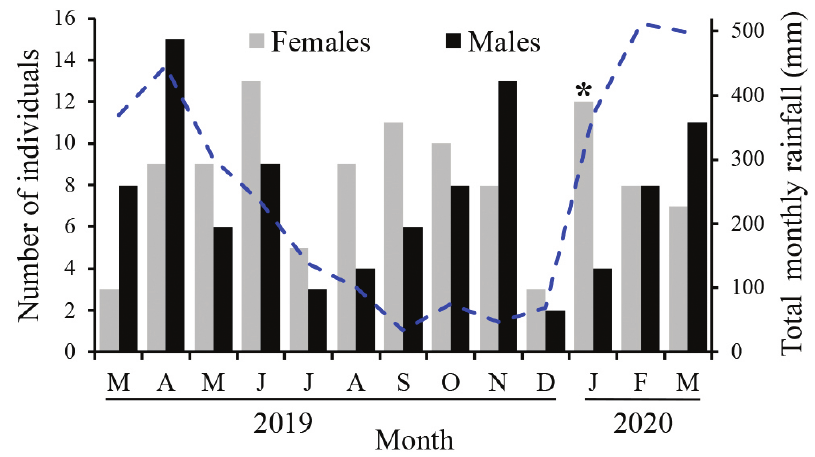
FIGURE 2 | The number of females and males Helogenes marmoratus collected in a catchment of the Guamá River in Capitão Poço, Pará State, Brazil, each month between March 2019 and March 2020. The dashed blue line represents the total monthly rainfall. * Indicates a significant difference in the sex ratio in that month.